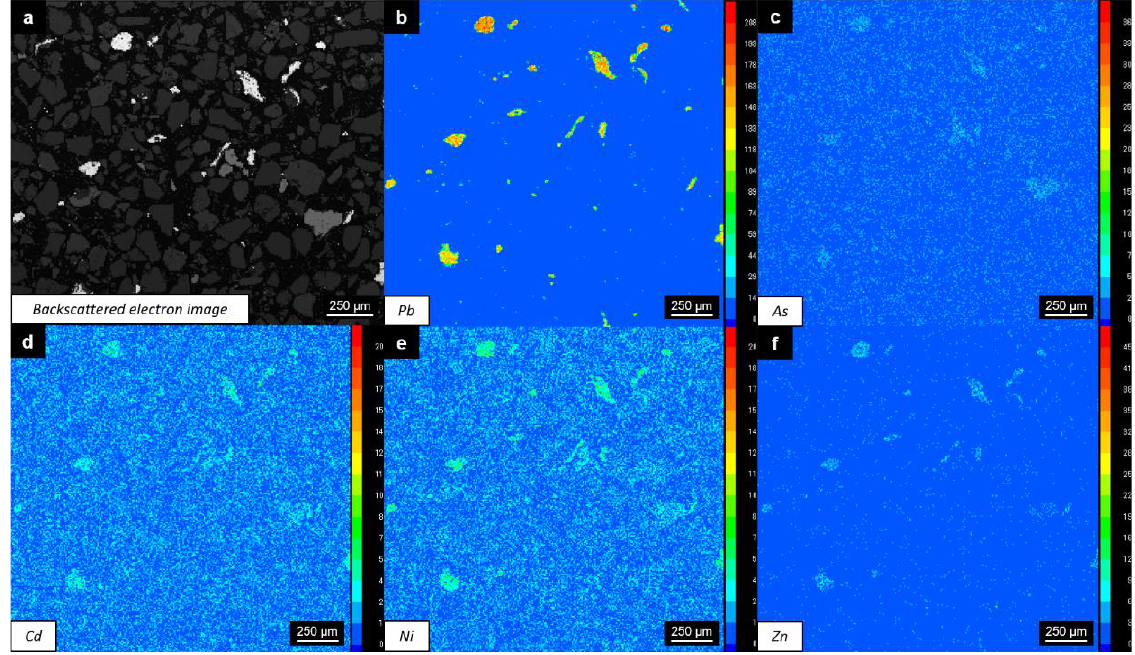
Figure 3. Element maps for ( a ) BSE image, ( b ) Pb, ( c ) As, ( d ) Cd, ( e ) Ni, and ( f ) Zn in soils from the shooting range obtained from EPMA analysis.